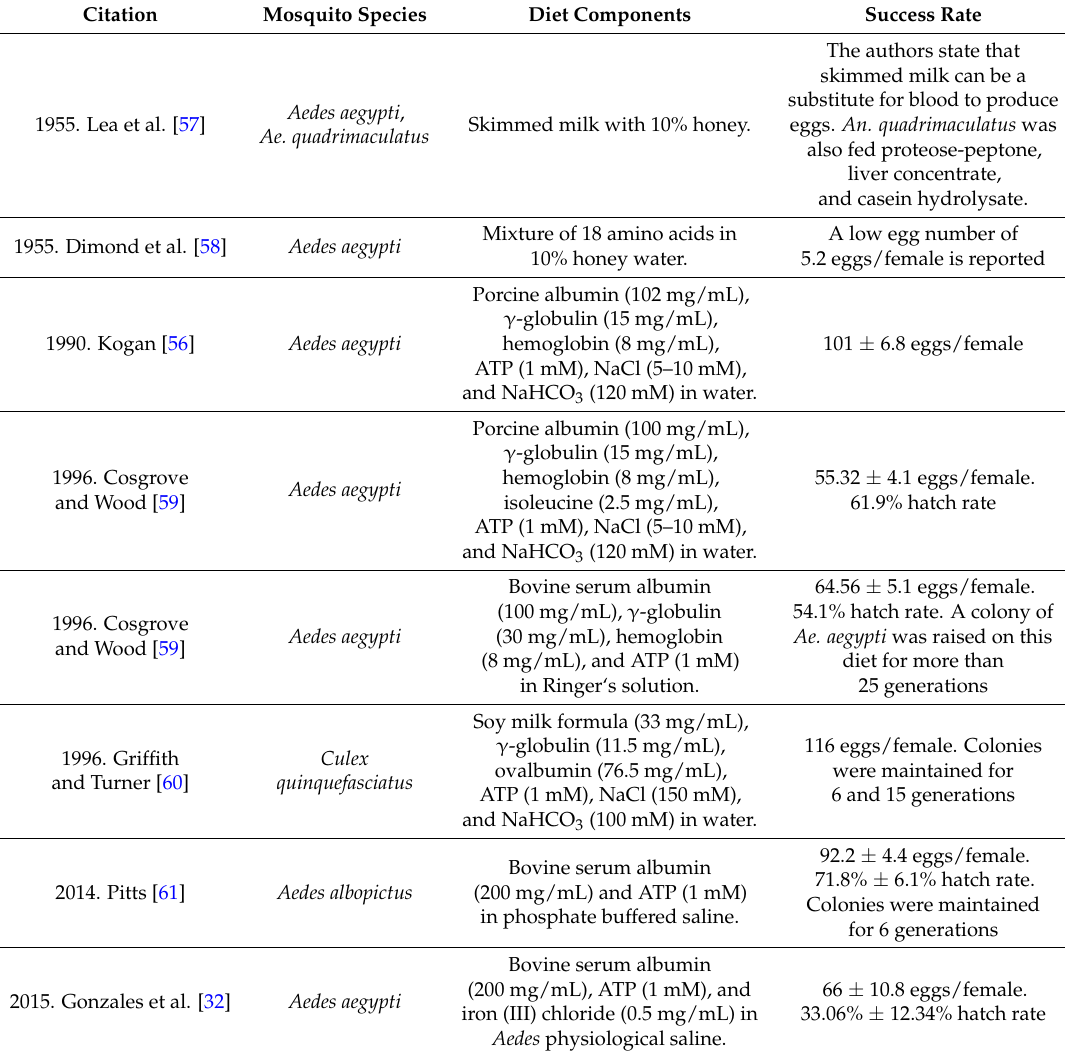
Table 1. A selection of publications on artificial blood meal replacement diets for